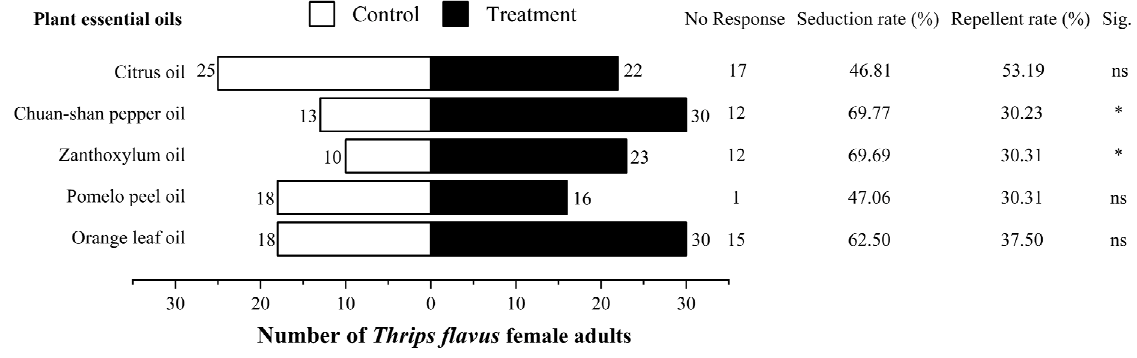
Figure 1. Olfactory behavioral response of Thrips flavus to five Rutaceae essential oils.